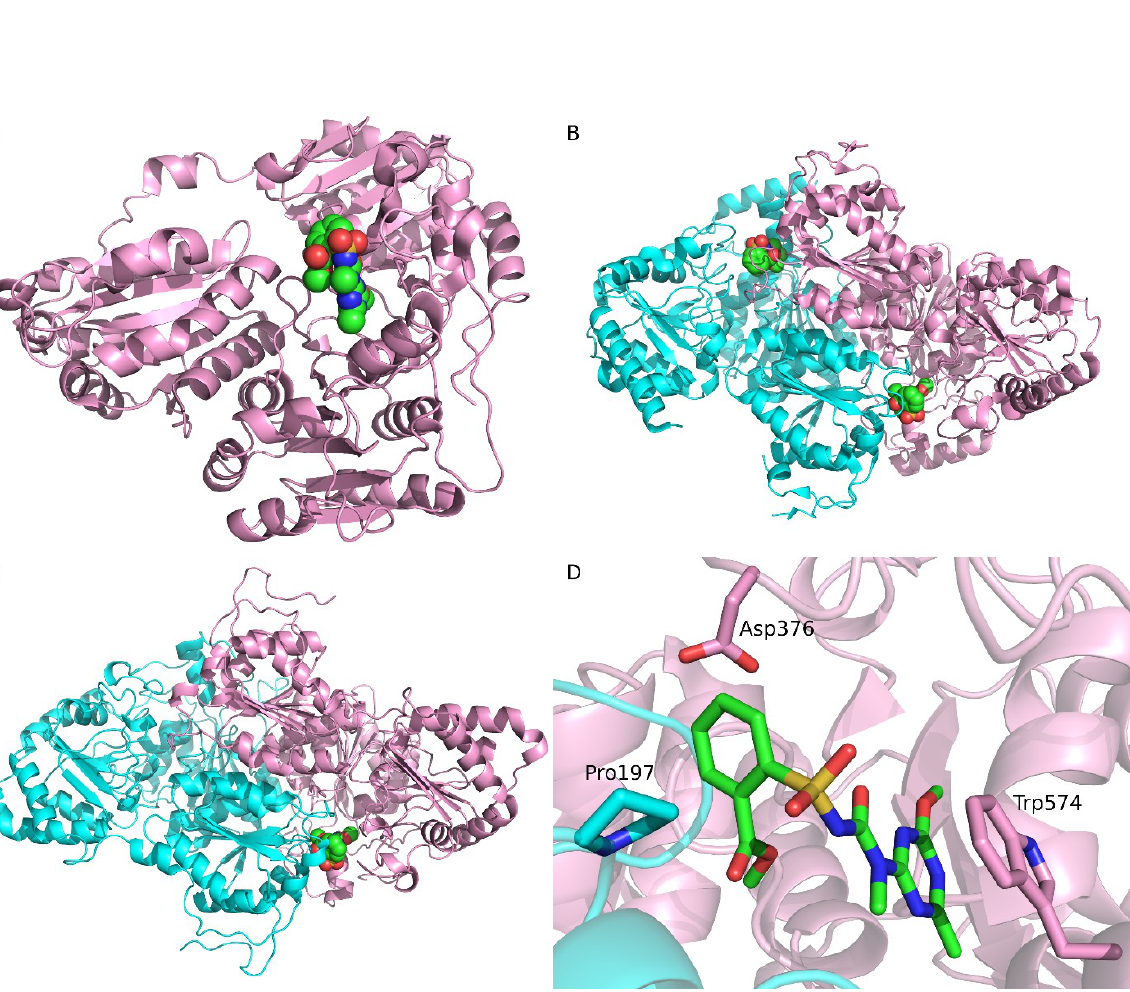
Fig 2. The complex structures of AHAS bound with tribenuron methyl. (A) The monomer structure of Arabidopsis thaliana AHAS ( At AHAS) bound with tribenuron methyl (1YI1). (B) The dimer structure of Saccharomyces cerevisiae AHAS ( Sc AHAS) bound with tribenuron methyl (1T9A). (C) The modeled dimer structure of Kochia scoparia AHAS ( Ks AHAS) bound with tribenuron methyl. (D) Important interactions between Sc AHAS and tribenuron methyl (1T9A). In panels A, B, and C, tribenuron methyl is displayed in spheres, indicating the binding site. In panels B, C, and D, the two chains of AHAS are colored pink and cyan, respectively. In panel D, tribenuron methyl and three important residues are shown in sticks. Carbons in tribenuron methyl are colored green.